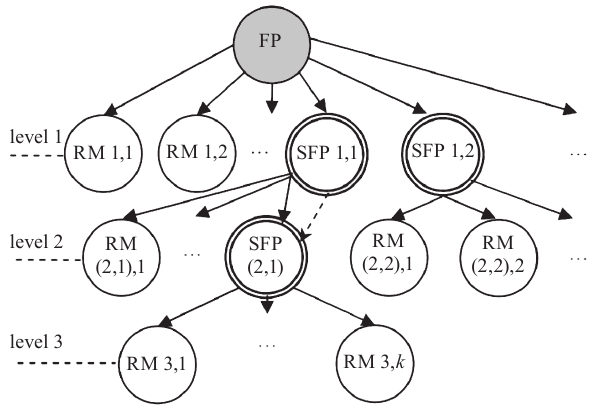
Figure 2 Hierarchical structure of the product formulation: FP – finished product; RM – raw materials; SFP – semi-finished product [23] branch of the hierarchical structure. According to Fig. 2, the calculation of the formulation begins with the semi-finished product FP (2, 1), since the path to its components is the longest in the hierarchy. The initial data for calculating the lowest level include the loading of all types of raw materials and semi-finished products, loss of dry matte, and a given amount of finished products equal to 1